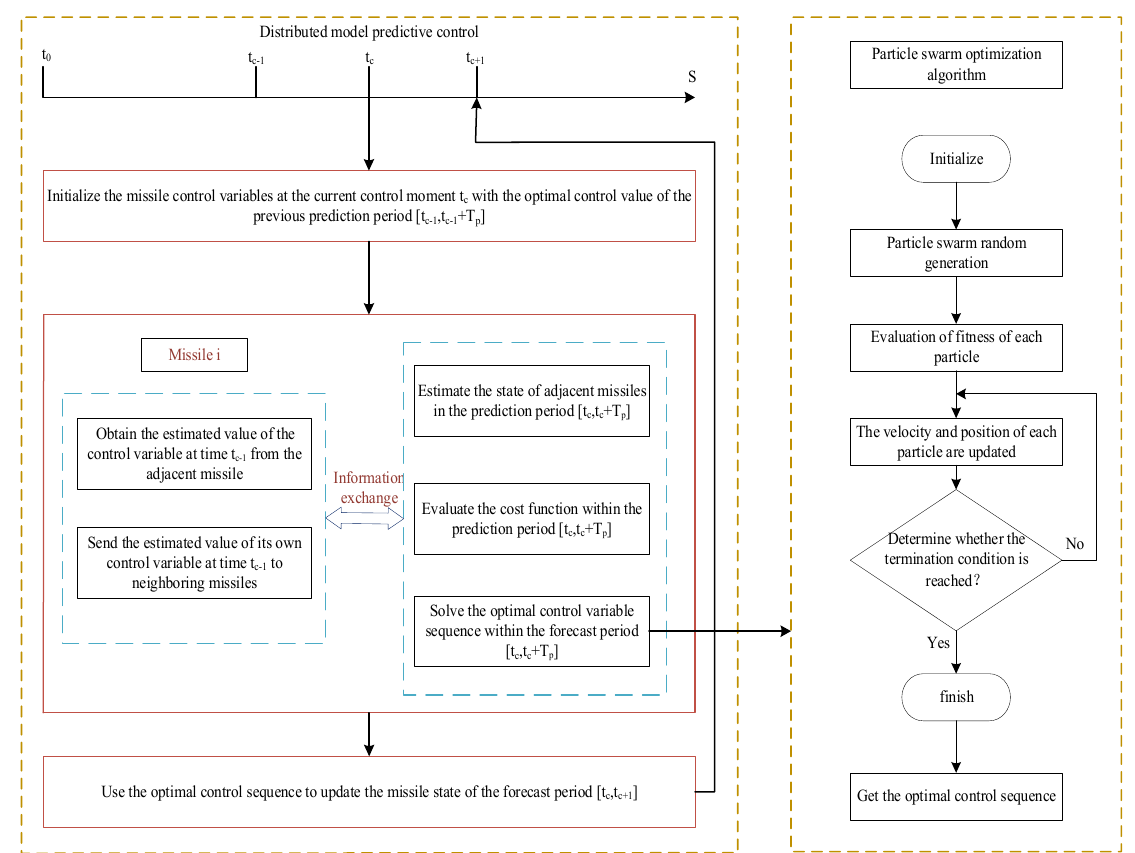
Figure 6. PSO-DMPC model prediction framework.